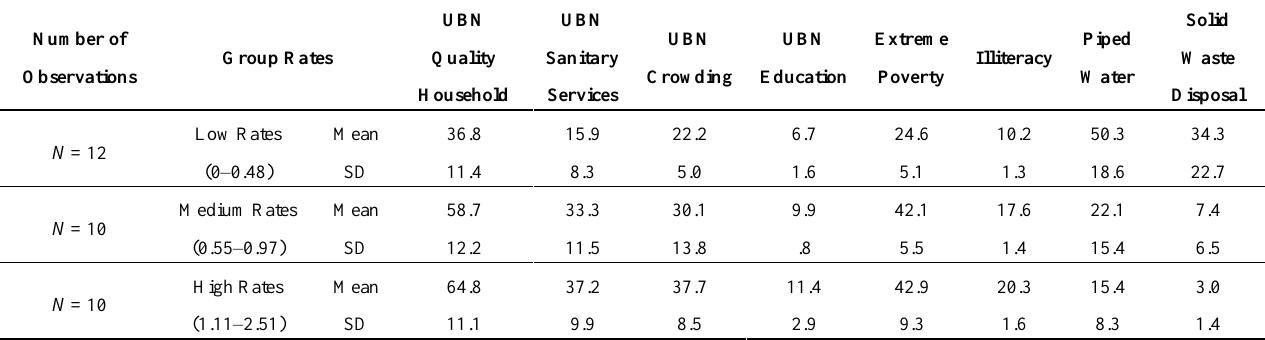
Table 3. Mean and standard deviation of the percentages of the socioeconomic variables in the grouped municipalities by log-transformed rates of leptospirosis between 2004 and 2010.